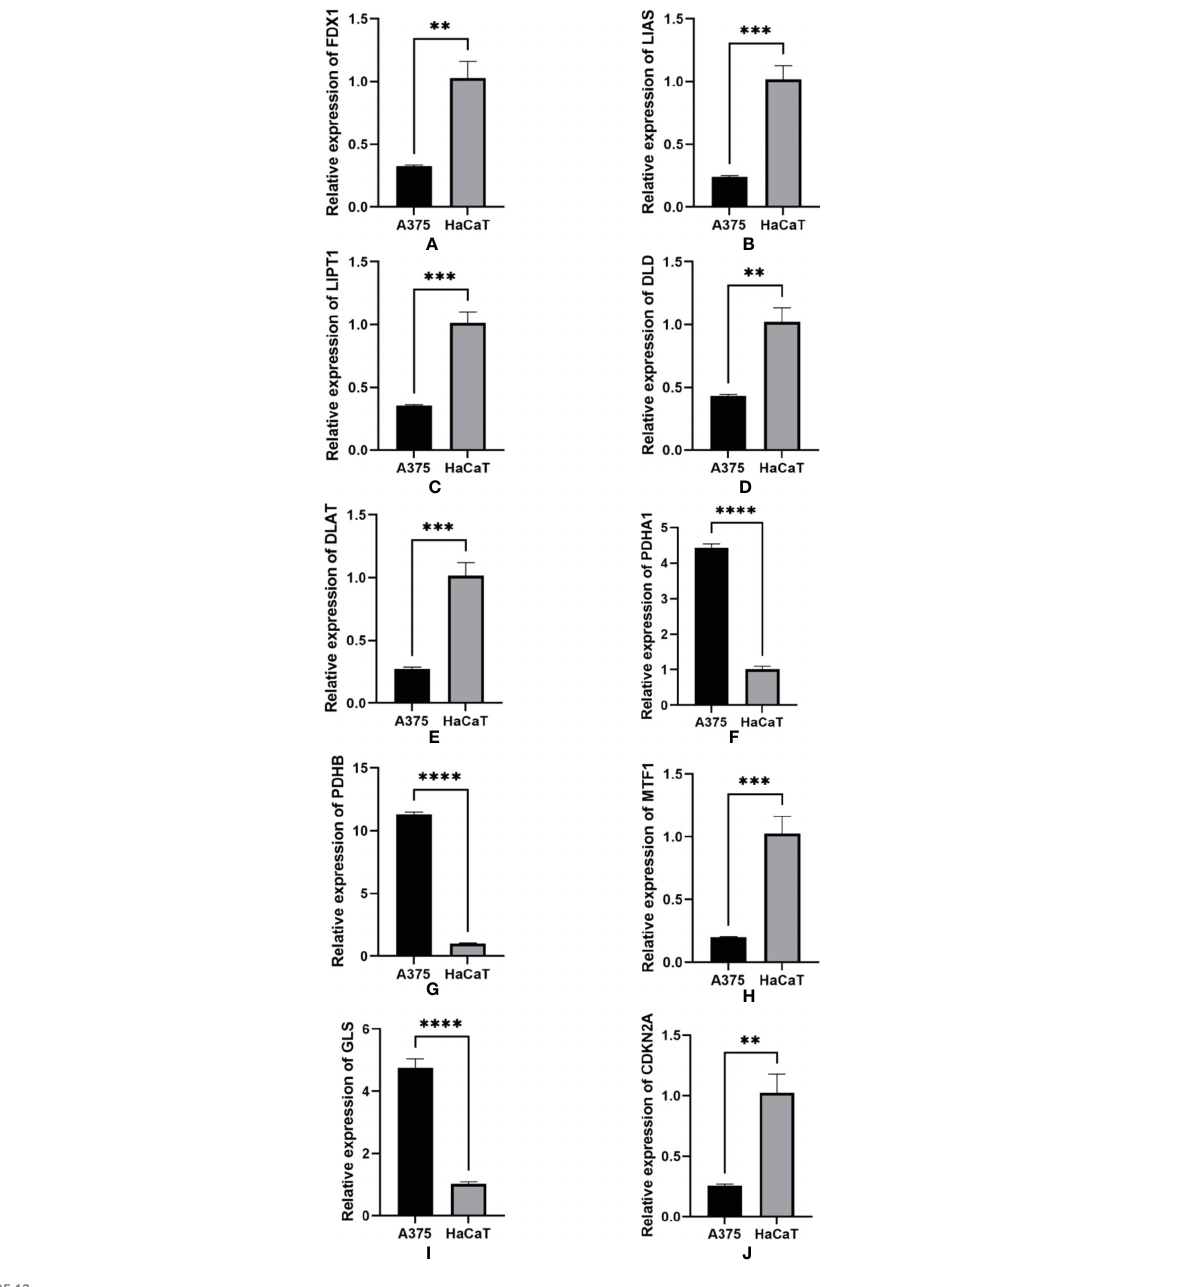
FIGURE 12 qRT-PCR was detected for the expression of RNA in A375 cell lines and HaCaT cell lines. (A) FDX1. (B) LIAS. (C) LIPT1. D.DLD. (E) DLAT. (F) PDHA1. (G) PDHB. (H) MTF1. I.GLS. (J) CDKN2A. GAPDH was used as an internal control. **p-value<0.01, ***p-value<0.001,